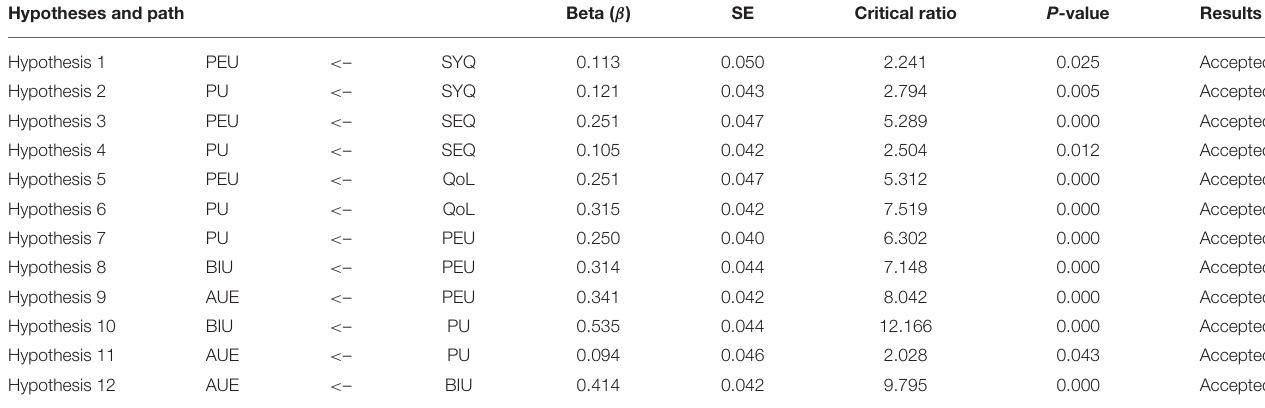
TABLE 5 | Results of hypotheses